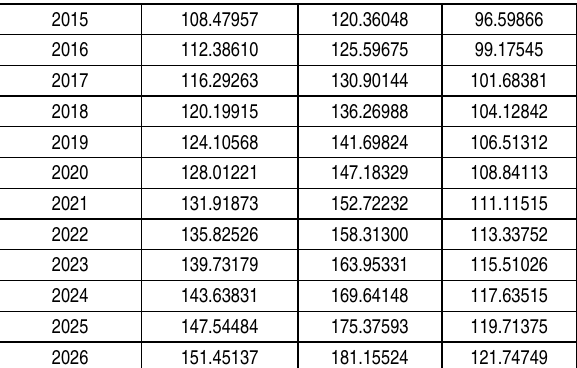
The plots in Figure 3 illustrate the logarithm of death rates for different causes of death ranging from 1979 to 2003.